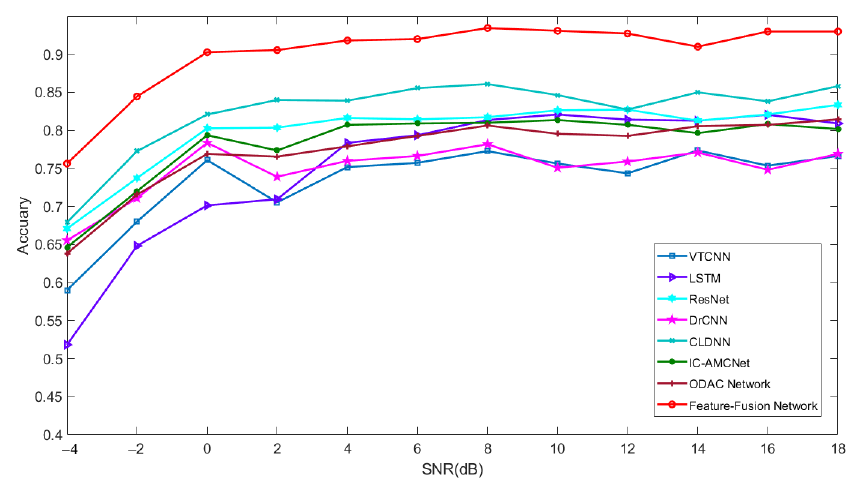
Figure 11. The comparison between different AMC